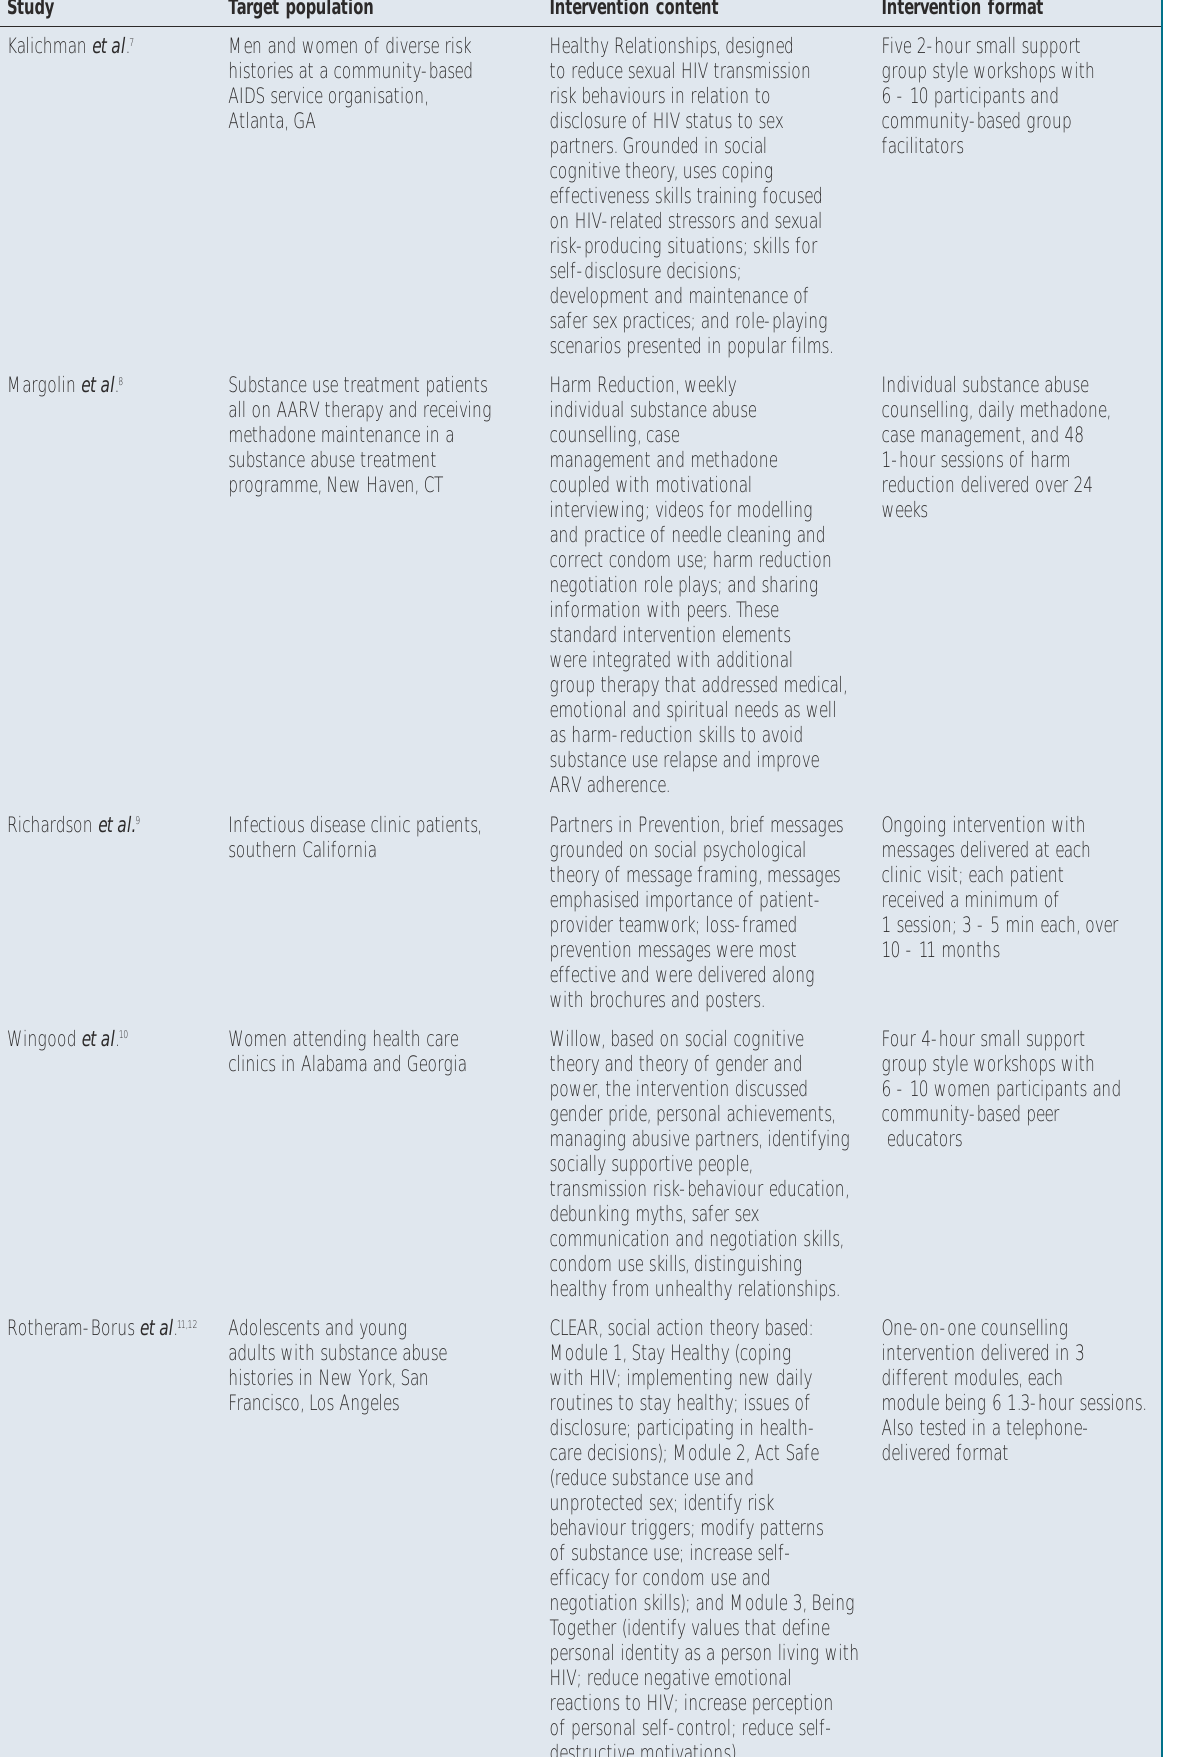
TABLE I. SUMMARY OF POSITIVE PREVENTION INTERVENTION CONTENT IN FIVE OF THE MOST PROMISING